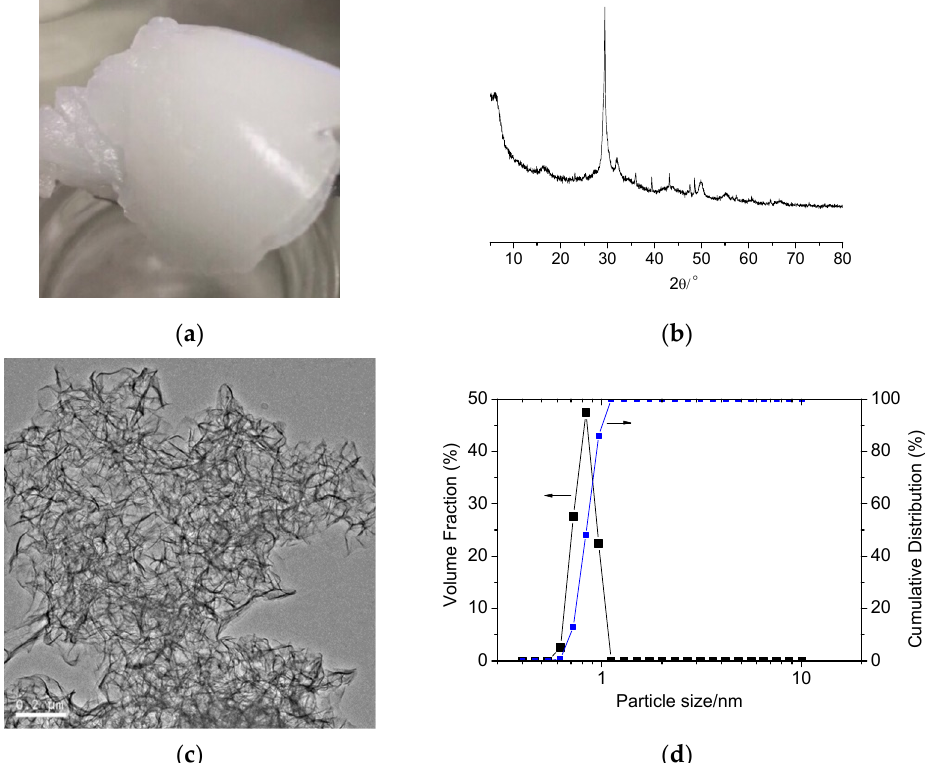
Figure 2. Characterization of the chemically synthesized C-S-H nanoparticles. ( a ) The gel; ( b ) XRD diagram; ( c ) TEM photograph and ( d ) particle size distribution.